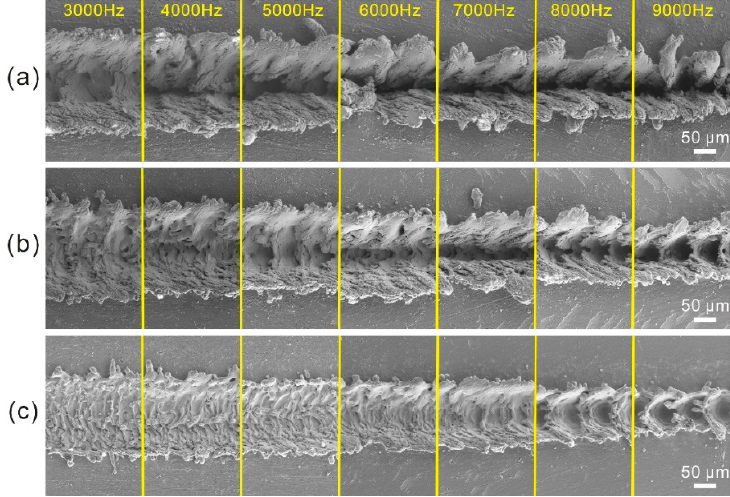
Figure 11. SEM image of the strip microstructure on Al alloy surface prepared by different laser beam pulse frequency: ( a ) 0.1 m/s; ( b ) 0.20 m/s; ( c ) 0.4 m/s.